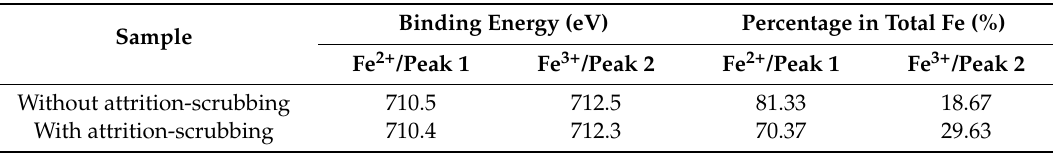
Table 10. The results of valence states and contents of iron elements before and after